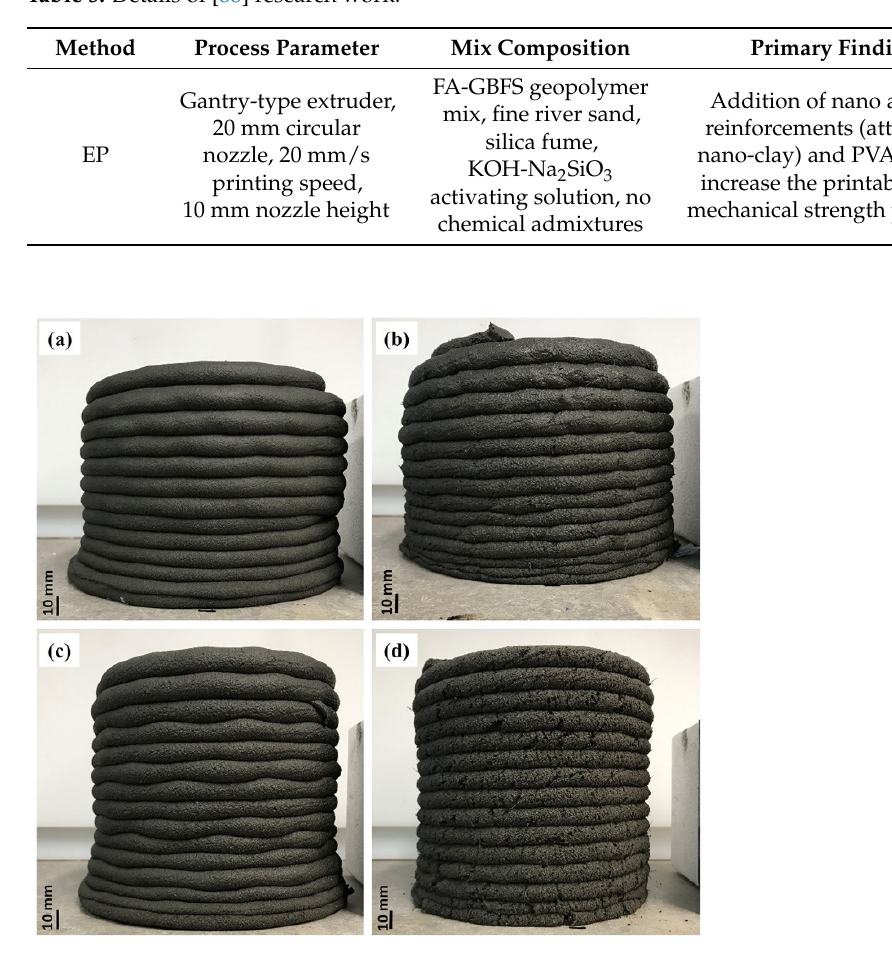
Figure 16. Buildability of geopolymeric printable composites reinforced with nano-clay additives and PVA fibers (reproduced with permission from Chougan, M. et al., Materials and Design ; Else- vier, 2021).